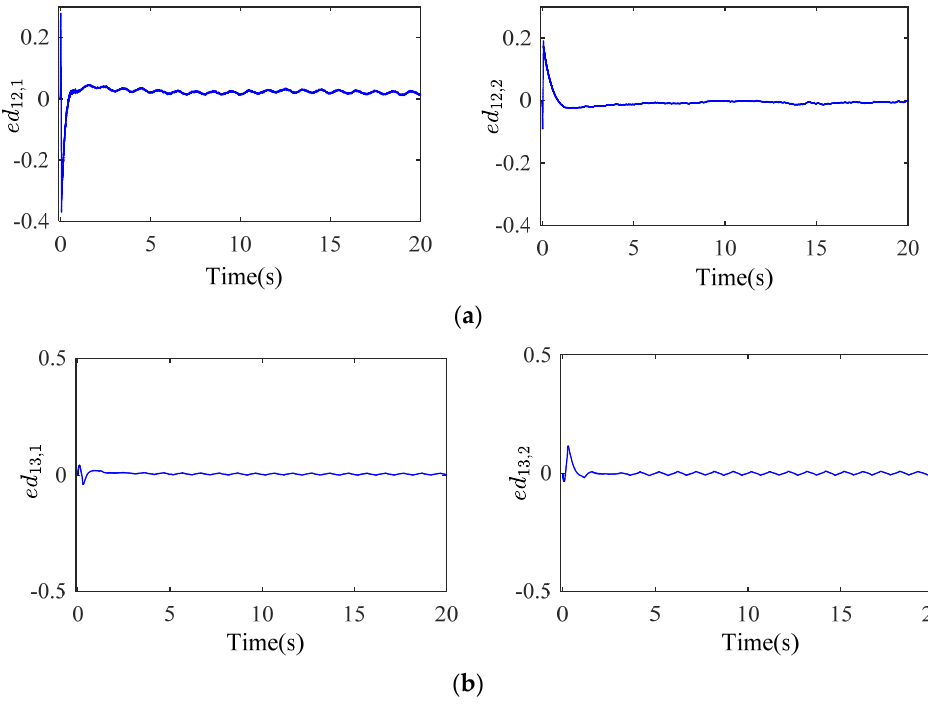
Figure 8. Estimate-error ( a ) e d 12 ; ( b ) e d 13 .